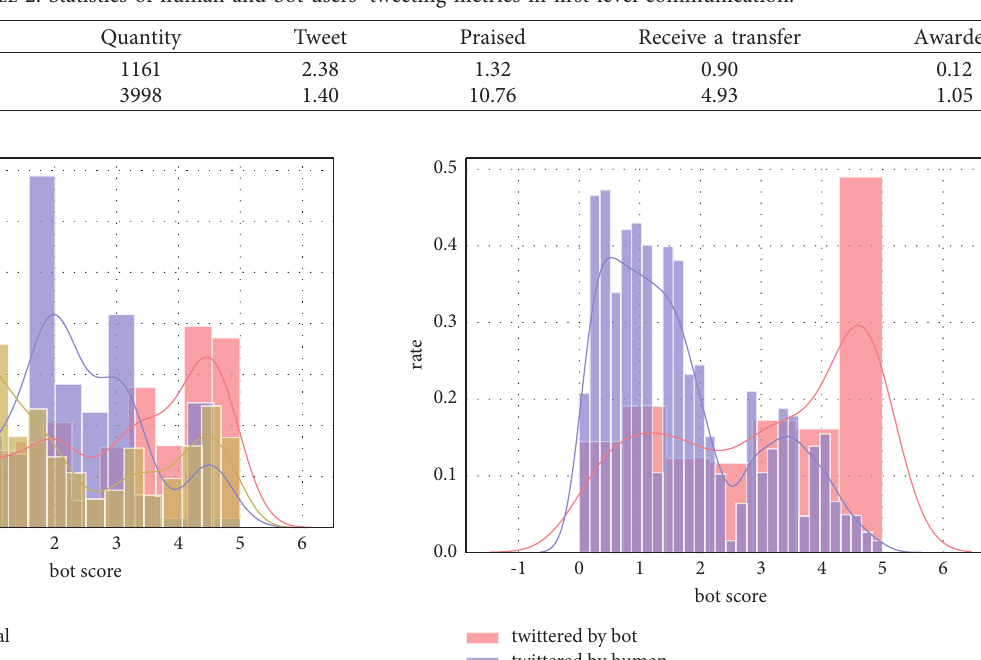
Table 2: Statistics of human and bot users’ tweeting metrics in first-level communication.